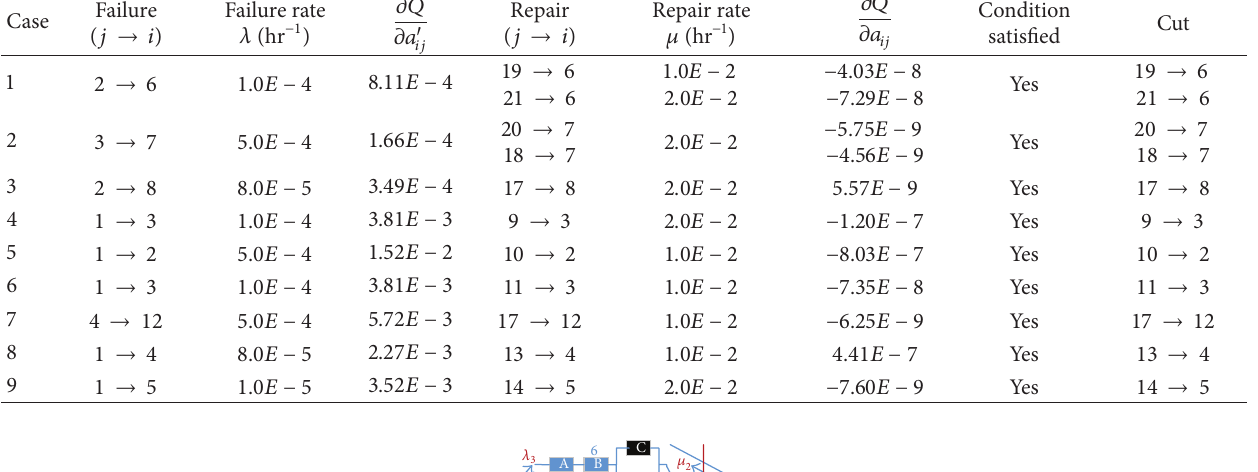
Table 2: Derivatives for the edge cutoff criterion.